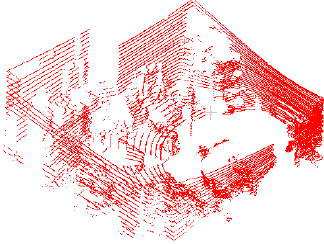
Figure 9. An example of the Velodyne HDL-32e data.